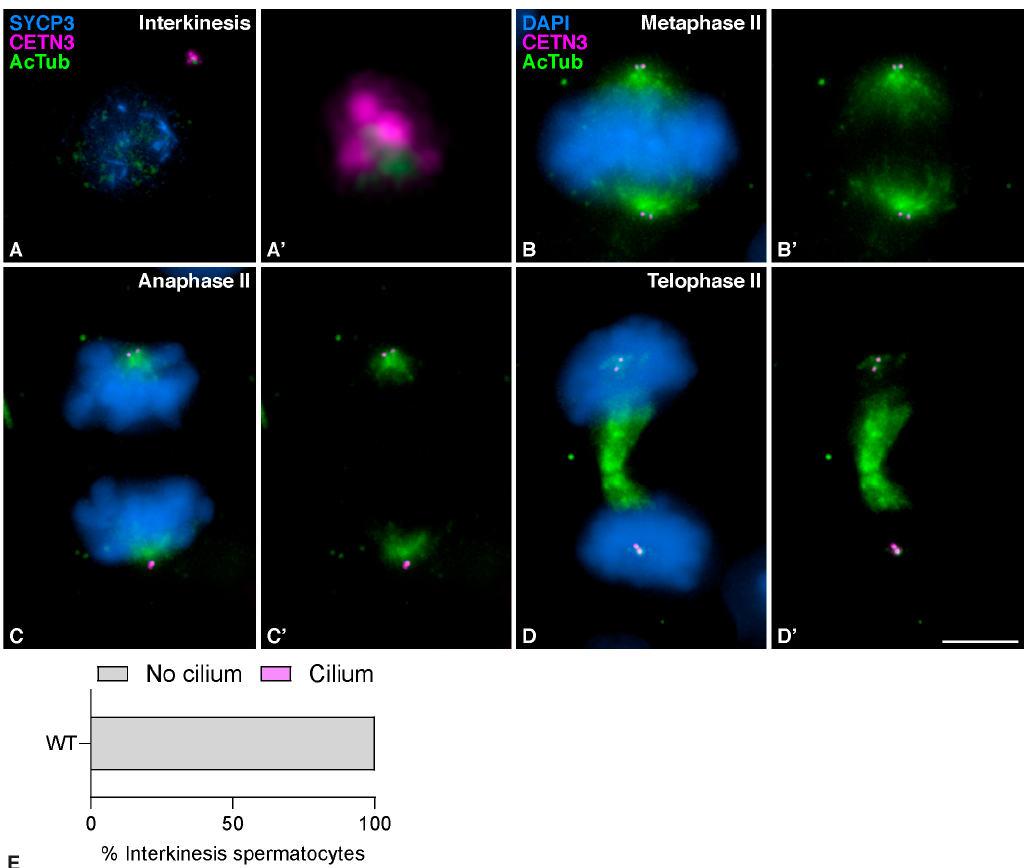
Figure 2. Mouse secondary spermatocytes do not present cilia. Detection of acetylated Tubulin in mouse spermatocytes during the second meiotic division. Triple immunolabelling of synaptonemal complex protein 3 (SYCP3) (blue), Centrin 3 (CETN3) (magenta) and acetylated Tubulin (AcTub) (green) on squashed WT mouse spermatocytes at ( A ) Interkinesis. And double immunolabelling of Centrin 3 (CETN3) (magenta) and acetylated Tubulin (AcTub) (green), with chromatin stained with DAPI (blue) at ( B ) Metaphase II, ( C ) Anaphase II ( D ) and Telophase II. For images ( A ′ ) the 300× magnification of the centrosomes is shown. ( E ) Graphical representation of the quantification of ciliated spermatocytes at interkinesis ( n = 100, three biological replicates). Scale bar in ( D (cid:48) ) represents 5 µ